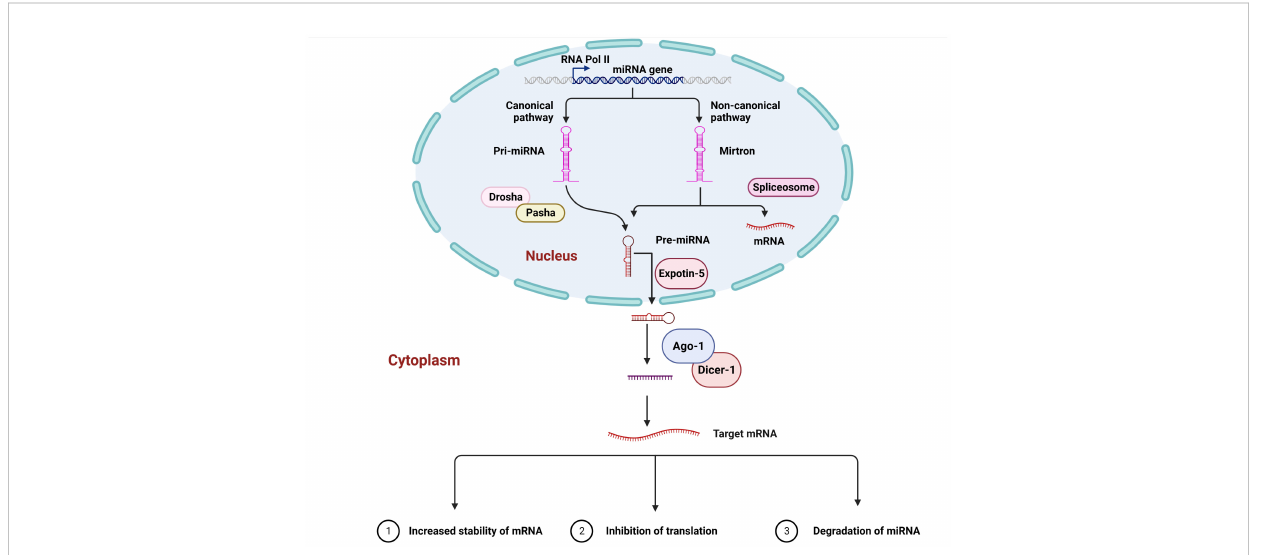
FIGURE 1 A canonical mechanism of microRNA biogenesis and their interaction. In living organisms, primary miRNA, like other cellular transcripts, contains a 5 ’ cap and a polyA tail. By cleaving the stem-loop at the base of the primary miRNA, the Drosha enzyme generates the precursor miRNA. Exportin-5 subsequently transports the precursor miRNA into the cellular cytoplasm. The Dicer-1 enzyme removes the hairpin head, resulting in the development of a miRNA duplex and, in turn, the production of the RNA-induced silencing complex, in which Ago1 is one of the crucial components. The miRNA passenger strand is generally degraded, whereas the guide strand is responsible for guiding the RNA-induced silencing complex towards the target mRNA, which is bound to either the open reading frame, the 5 ’ Untranslated Region, or the 3 ’ Untranslated Region. This interaction causes mRNA degradation, translation inhibition, and, in some cases, increased mRNA